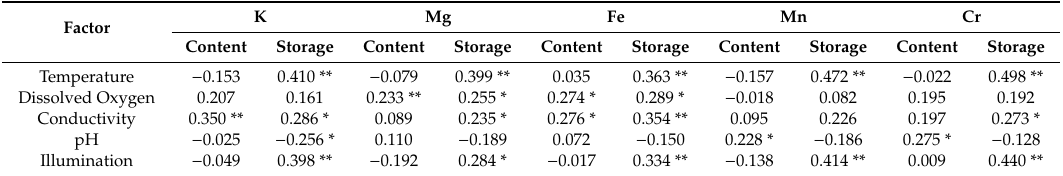
Table 7. Correlation coe ffi cients ( r ) between the environmental factors and the concentrations and storages of metals in the